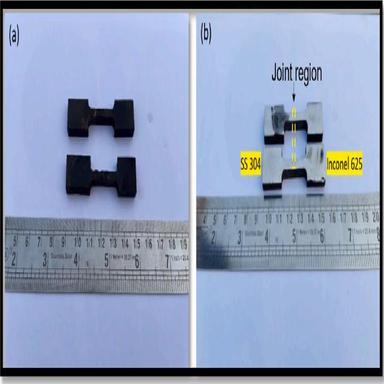
Tensile Specimen (a) Before polish (b) After Polish.